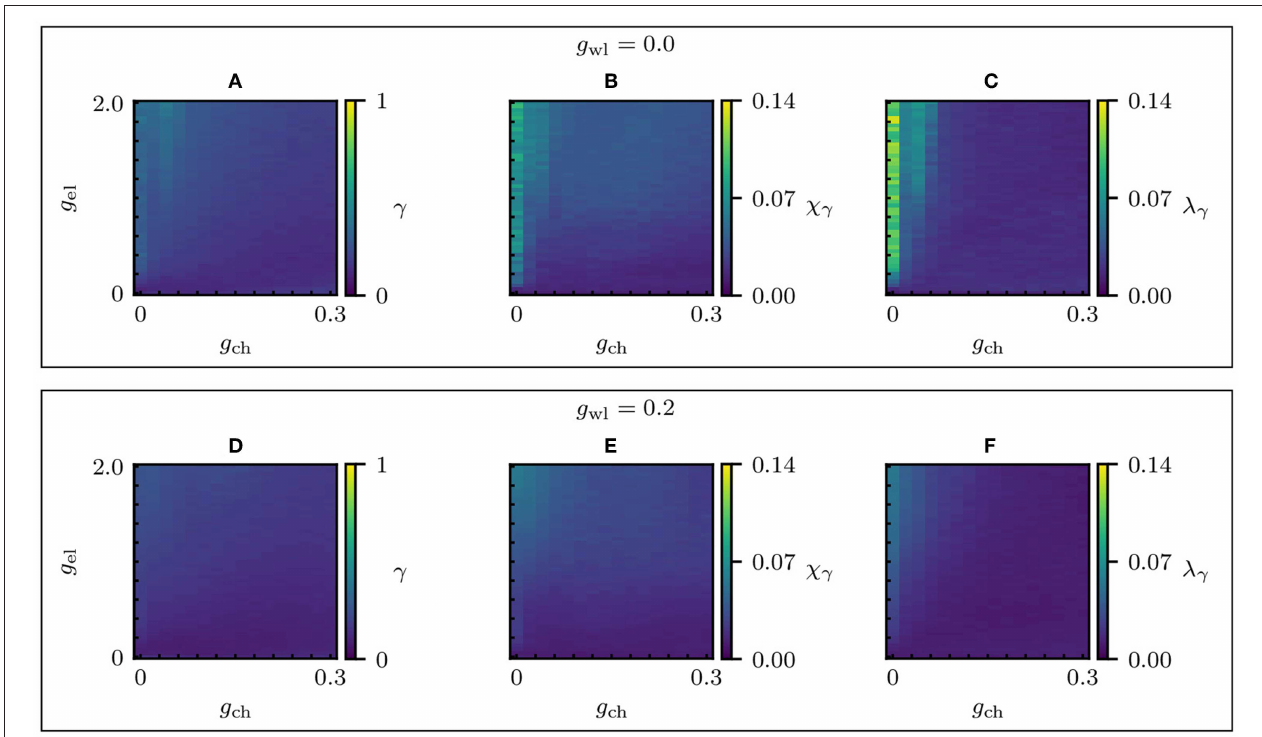
FIGURE 6 | Synchronization parameter scans of the Multilayer-Louvain network. Changes in the global dynamical properties as the electric and chemical coupling strengths vary. (A–C) Absence of wireless coupling ( g wl = 0) for different electrical and chemical couplings: the global level of synchronization of the whole network γ , the chimera-like index χ γ and the metastability index λ γ . (D–F) γ , χ γ , and λ γ for g wl = 0.2. The system parameters are the same as in Figure 3 , except for g wl .